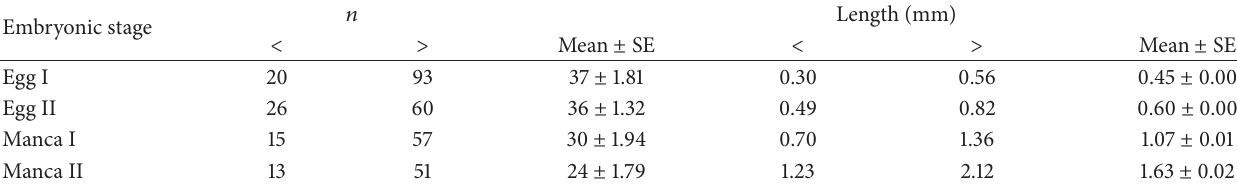
Table 1: Fecundity of Monokalliapseudes schubarti , using 80 females per developmental stage. Embryonic stage